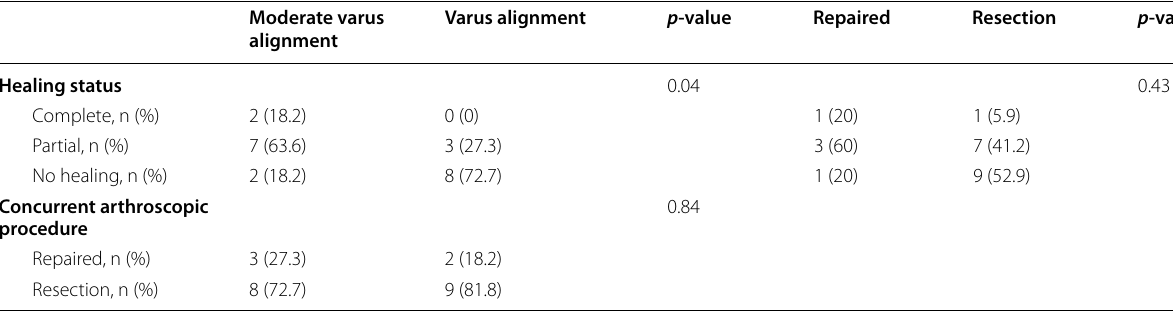
Chi-squared and Cochran-Armitage tests were used